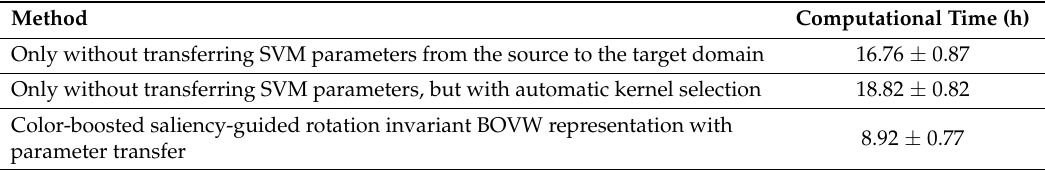
Table 7. The superiority of the color-boosted saliency-guided rotation invariant BOVW representation with parameter transfer method in reducing computational time in the SIRI-WHU dataset compared with other state-of-the-art